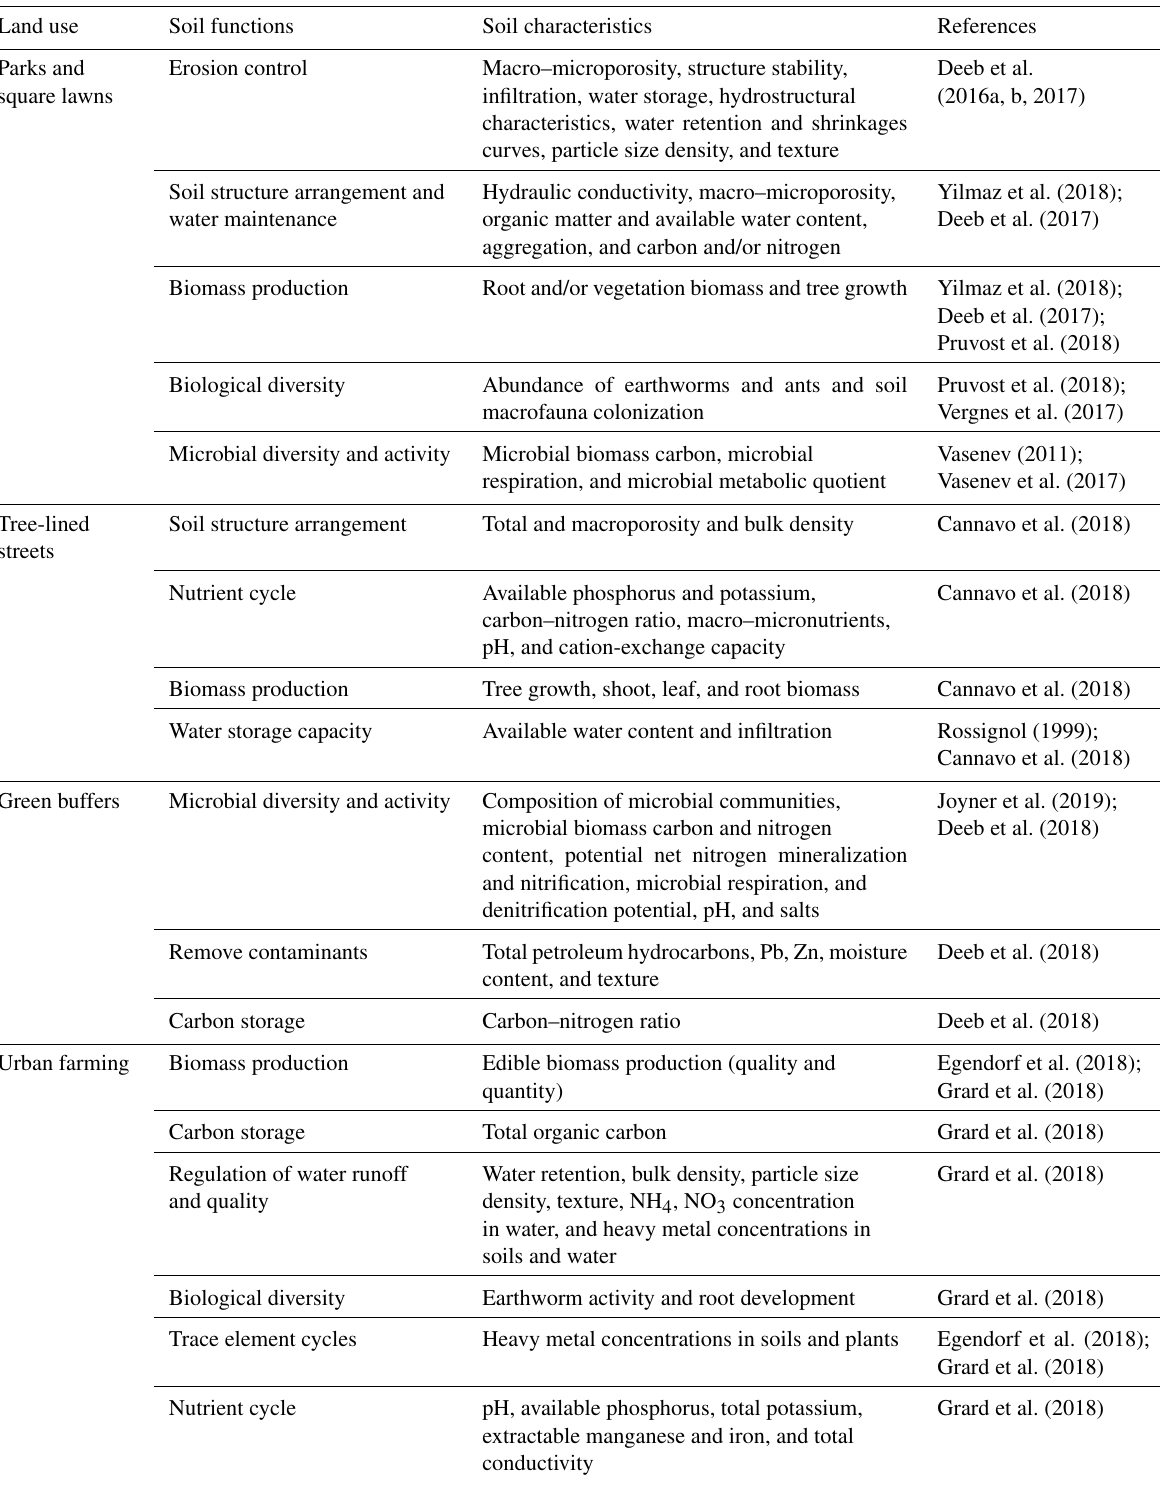
Table 1. Soil characteristics of constructed Technosols considered for assessing soil functions by different land uses of green infrastructure, as provided by the